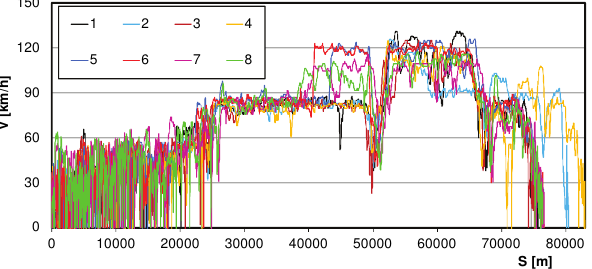
Fig. 3. All RDE tests were characterized by similar parameters and had similar speed